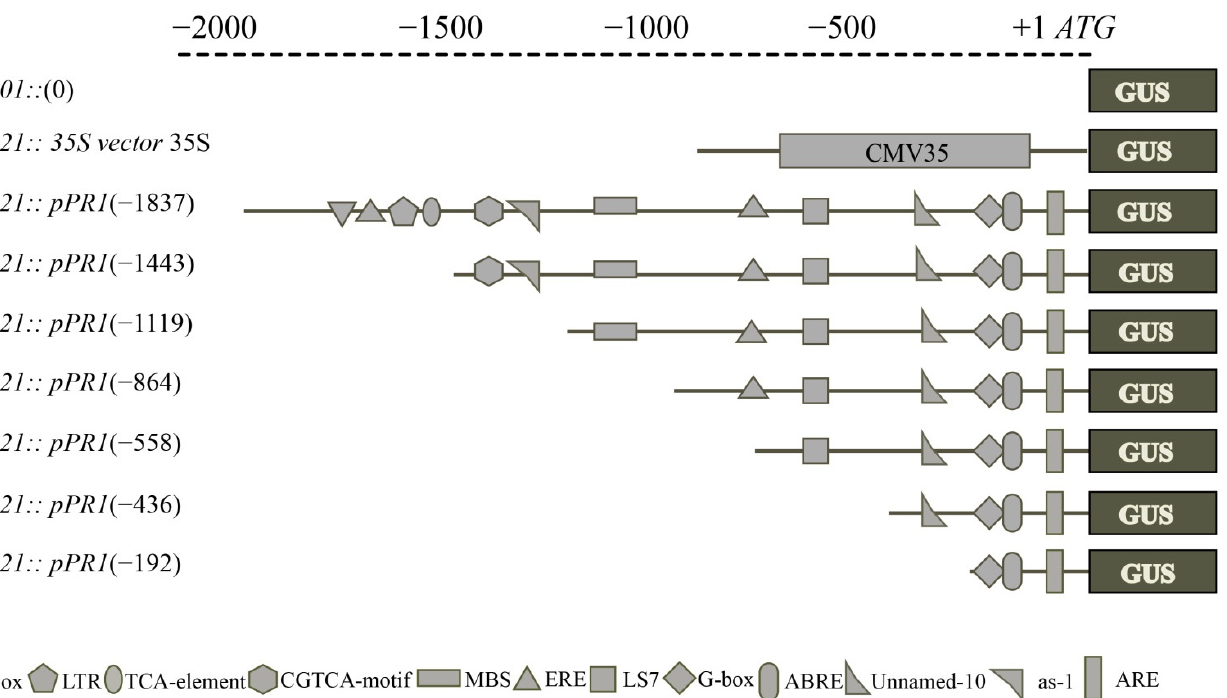
Figure 8. Schematic representation of the VvPR1 promoter constructs for examining GUS expression in tobacco leaves. The constructs of serial deleted promoter fragments of the VvPR1 gene were fused to the GUS reporter gene in the vector pBI ‐ 121 .